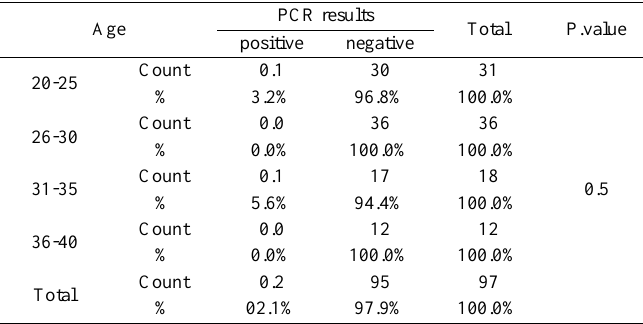
Table 2 : Correlation between PCR results and age